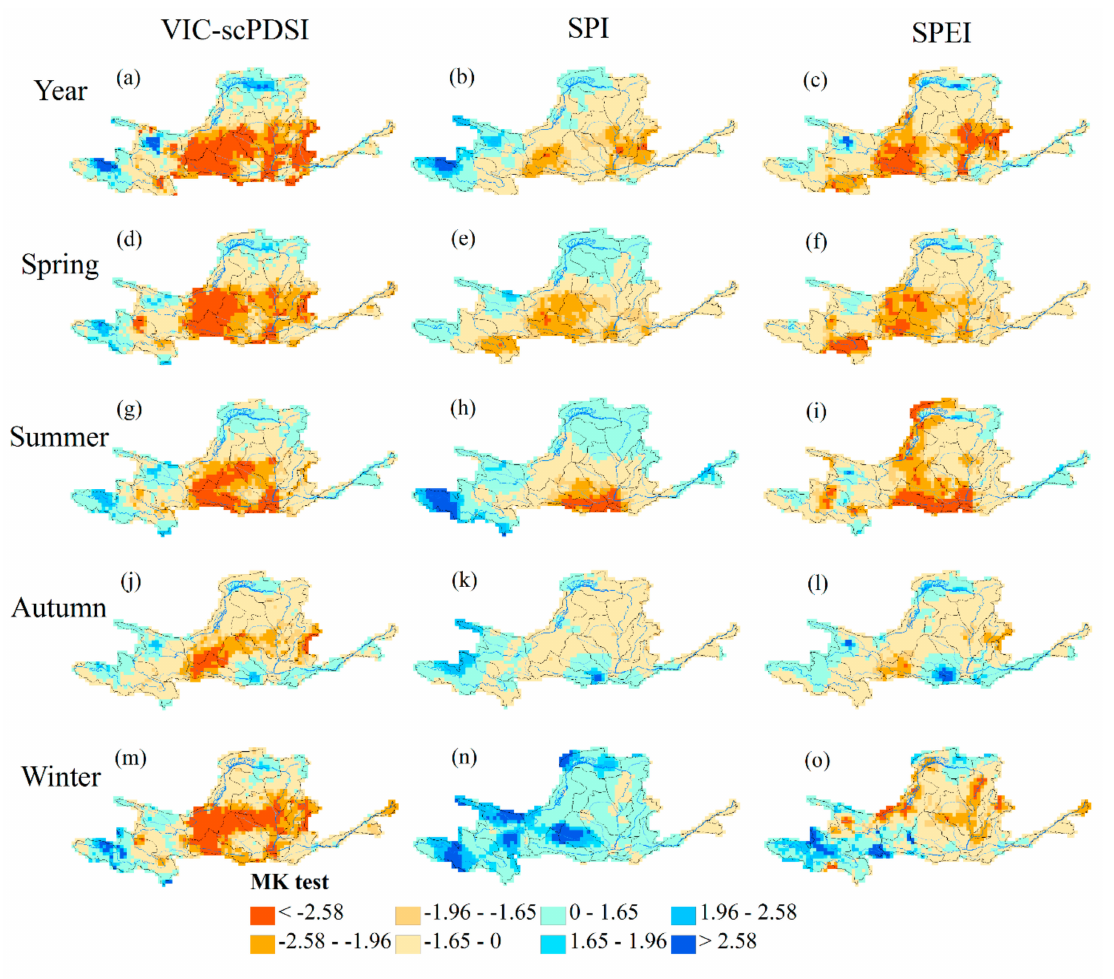
Figure 8. Spatial distribution of MK test statistics for annual and seasonal index values of VIC-scPDSI9 (left column), SPI3 (middle column), and SPEI3 (right column), respectively. The absolute values of MK statistics of 2.576, 1.96 and 1.645 correspond to the 1, 5 and 10% significance levels,